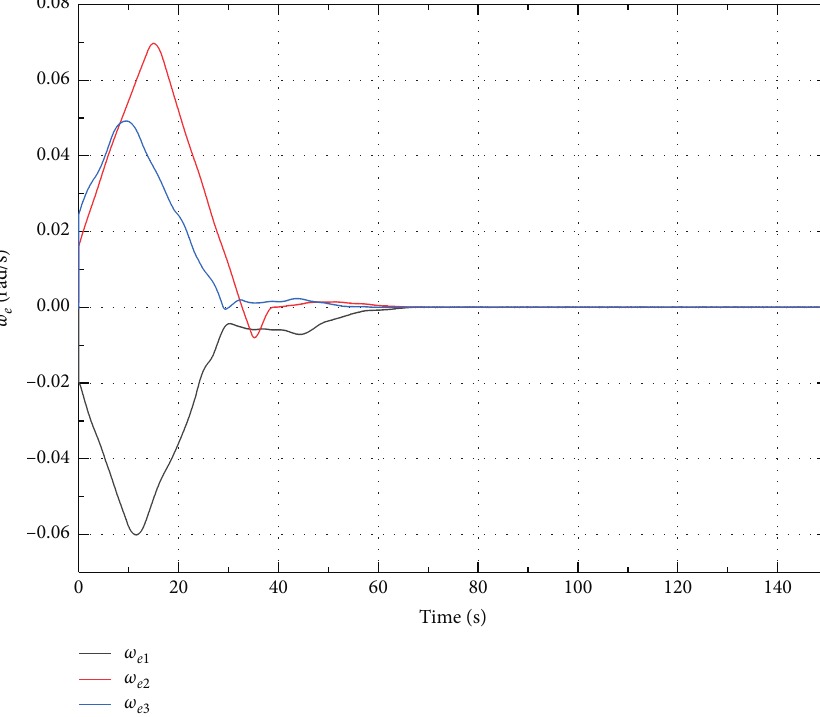
Figure 3: Trajectories of the error of attitude angular velocity of